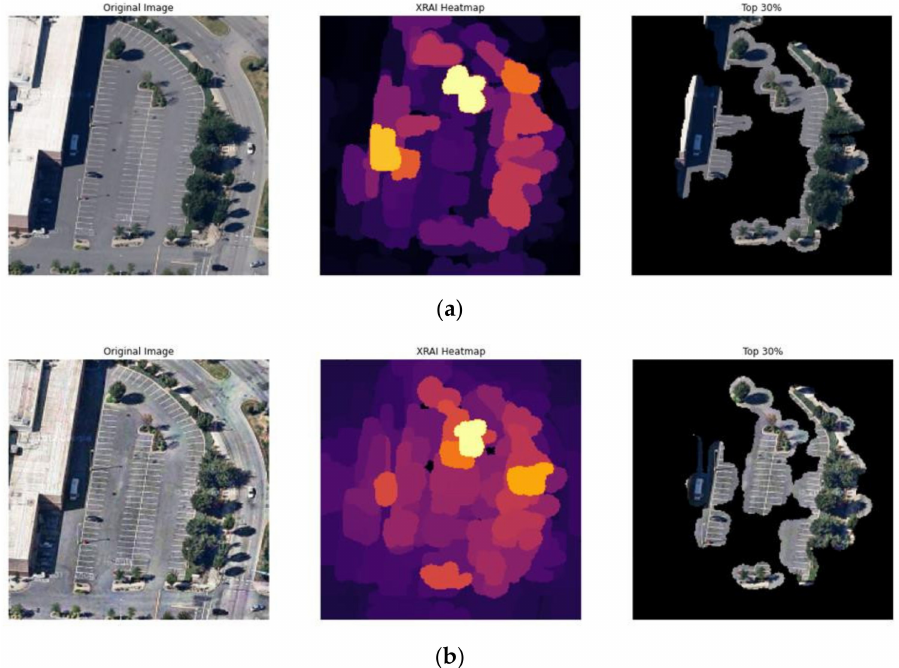
Figure 15. Parking lot image with XRAI analysis. ( a ) Original image (predicted as industry); ( b ) improved